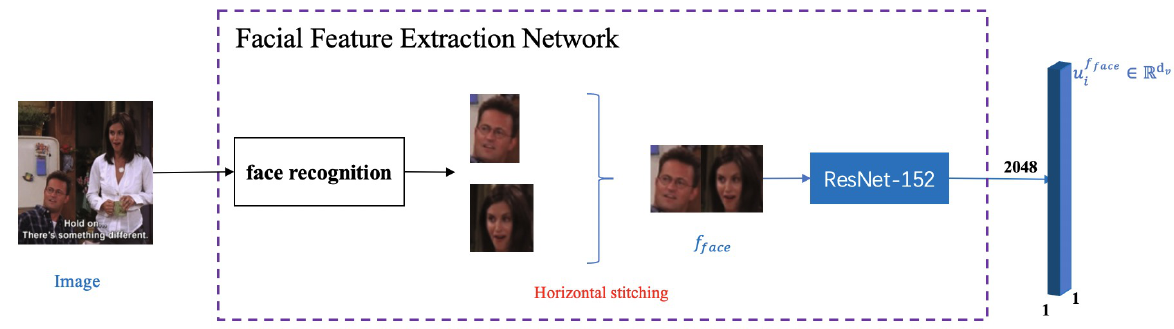
Figure 3. Facial feature extraction network architecture diagram. In the above, face recognition uses the face detection model provided by DLIB. ResNet-152 is a residual learning network proposed by He et al. [14]. This network is one of the most commonly used backbone networks in image classification tasks. The objects processed in our dataset are videos, so we use this architecture to average the features obtained from each frame in the video as the final facial feature